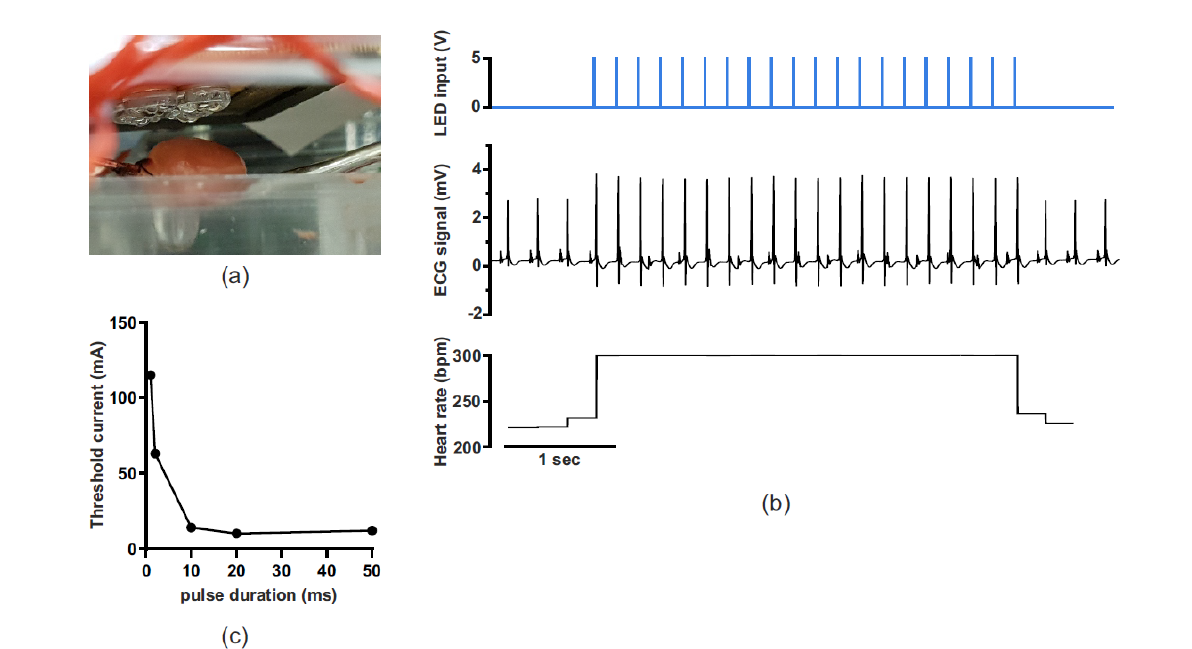
Figure 8. ( a ) Horizontally placed explanted mouse heart perfused in Langendorff configuration with the four LED matrix placed about 3 mm above for illuminating the left anterior ventricular wall of ∼ 10 mm × 7 mm. ( b ) Example trace for optogenetic pacing at 300 beats per minute (bpm) with 10 ms light pulses (blue line top, indicating TTL trigger voltage for the constant current driver), ECG traces (in mV, middle) and heart rate analysis (in bpm, lower). Note the change in ECG shape due to ventricular pacing, the 1:1 coupling to light pulses and the stable heart rate upon pacing. ( c ) Threshold current for reliable optogenetic pacing versus pulse duration for the four LED